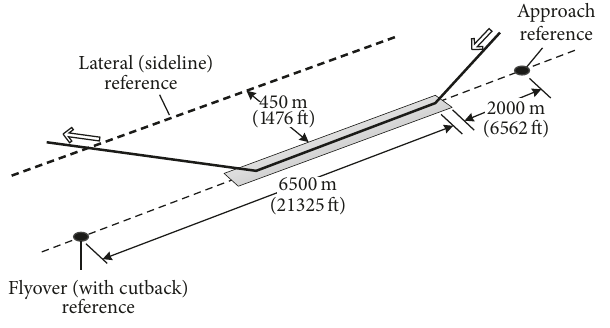
Figure 9: Noise certification